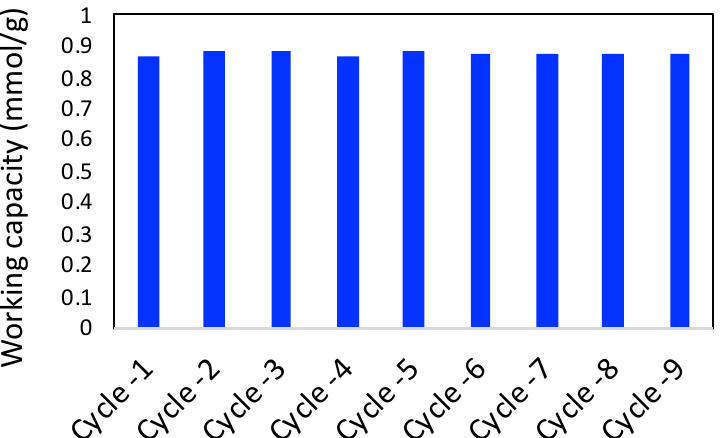
Figure 10. Cyclability of working capacity of CO 2 adsorption on 3D printed porous carbon monolith.